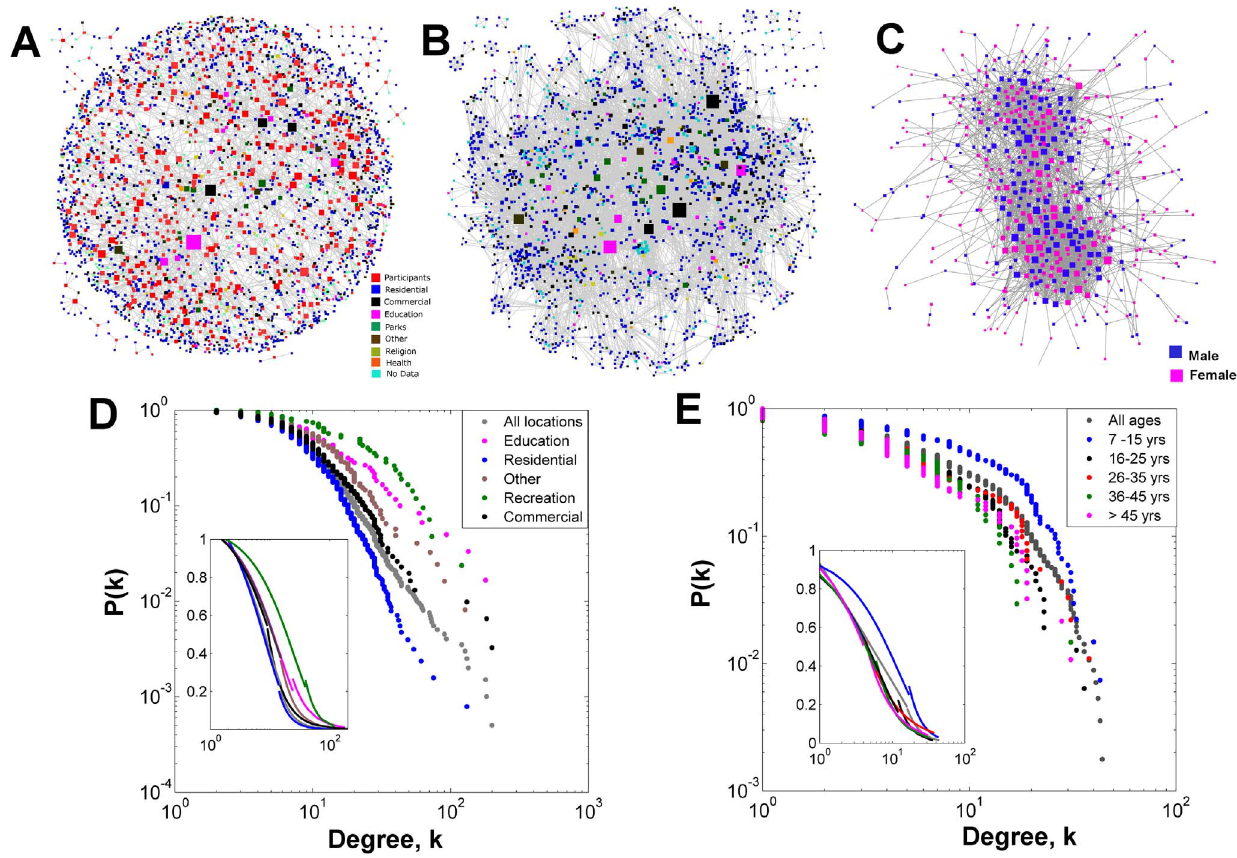
Figure 2. Mobility networks inferred from GPS data-logger data. (A) Networks expressed as an undirected bipartite ( N ij ) graph. N ij was projected into, N L describing the connections between locations visited by the same individuals (B) and N P connecting individuals visiting the same locations (C). Frames (D) and (E) show the empirical (main plot) and predicted (inset) degree distributions for N L and N P , respectively. See Table 1 for a glossary of network topology terms. The highly focal movement of individuals made it difficult to meaningfully map N ij , N L and N P in geographic space (Figure S5 in File S2).